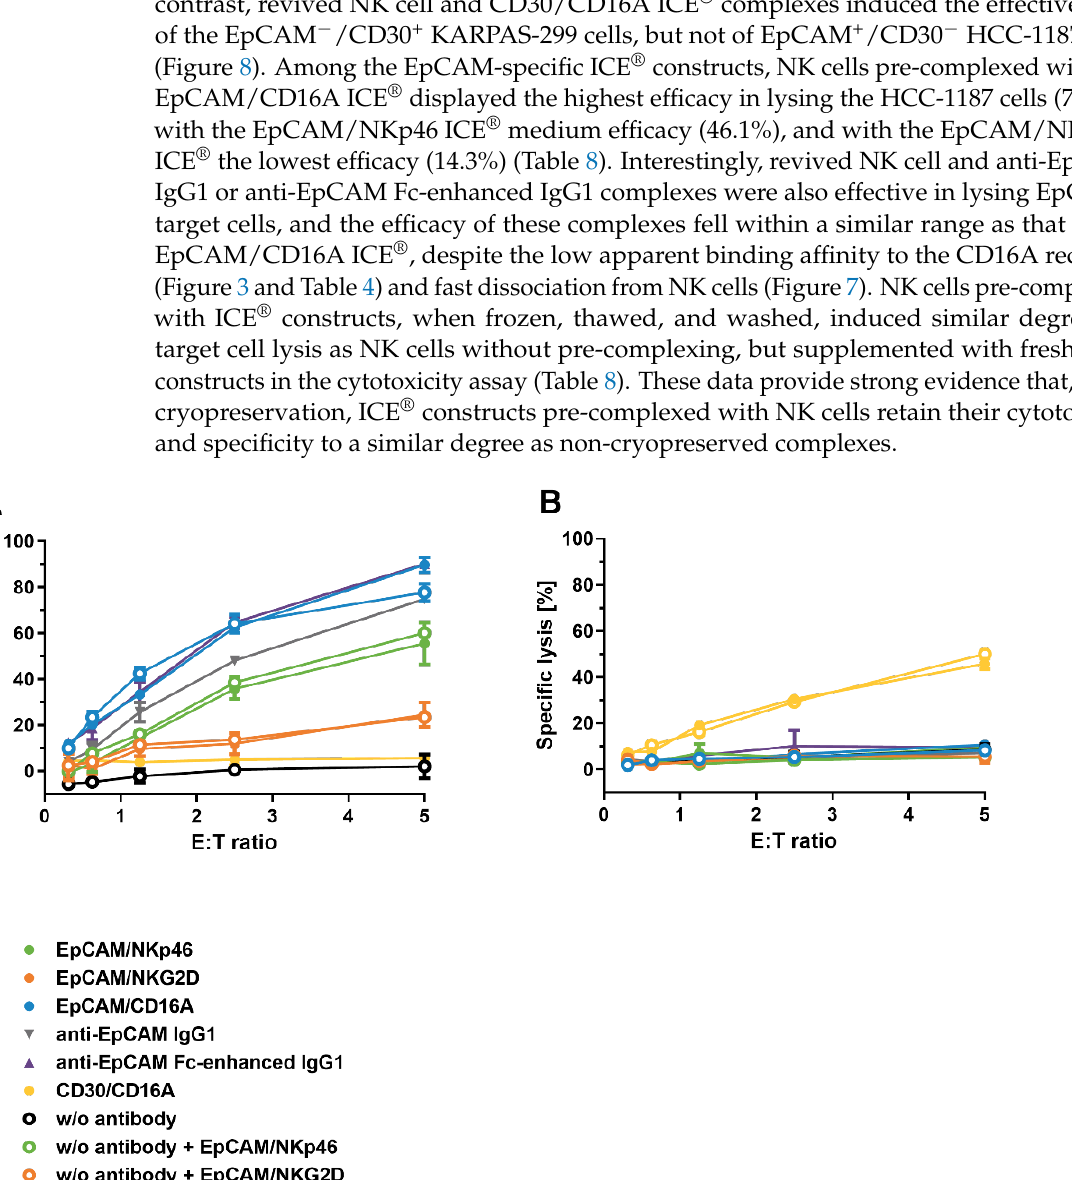
ICE ® Construct-NK Cell Complexes